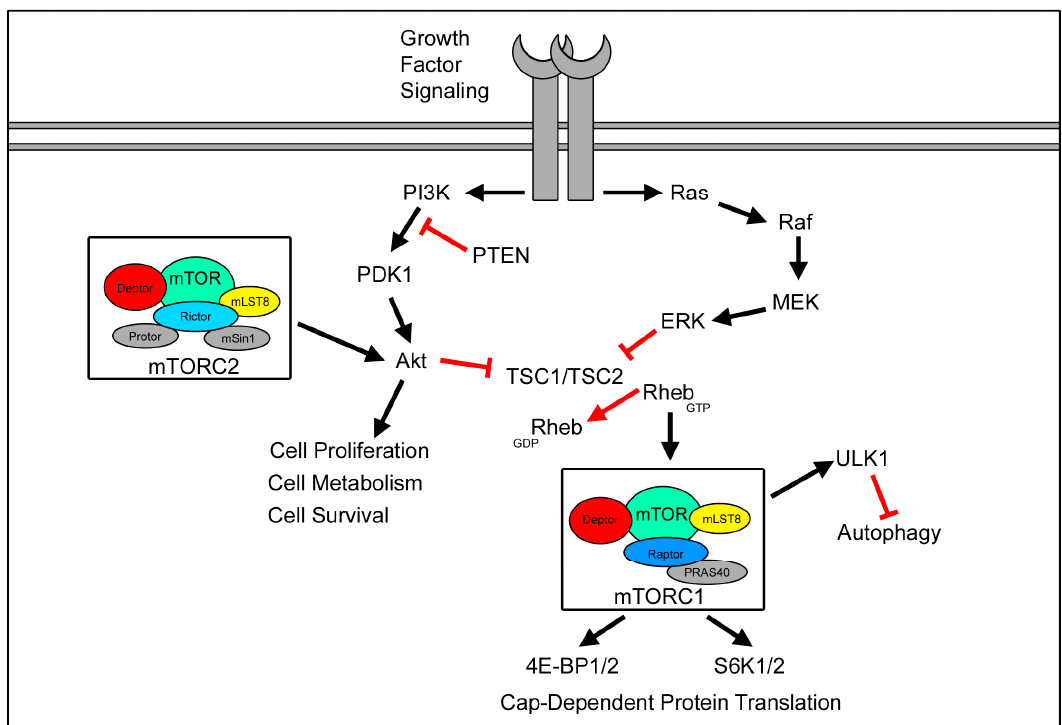
Figure 1. Overview of the mammalian target of rapamycin (mTOR) signaling pathway. mTOR signaling is activated in several ways, including growth factors, amino acids, and increased cellular energy. Growth factors can activate both mTOR complexes or PI3K and ERK signaling. mTORC2 phosphorylates Akt at S473 to enhance activation. In turn, Akt suppress TSC2, which suppresses Rheb. Additionally, ERK can inhibit TSC2 to promote mTORC1 activation. Phosphorylation of 4E-BPs and S6K1/2 by mTORC1 promote cap-dependent translation.